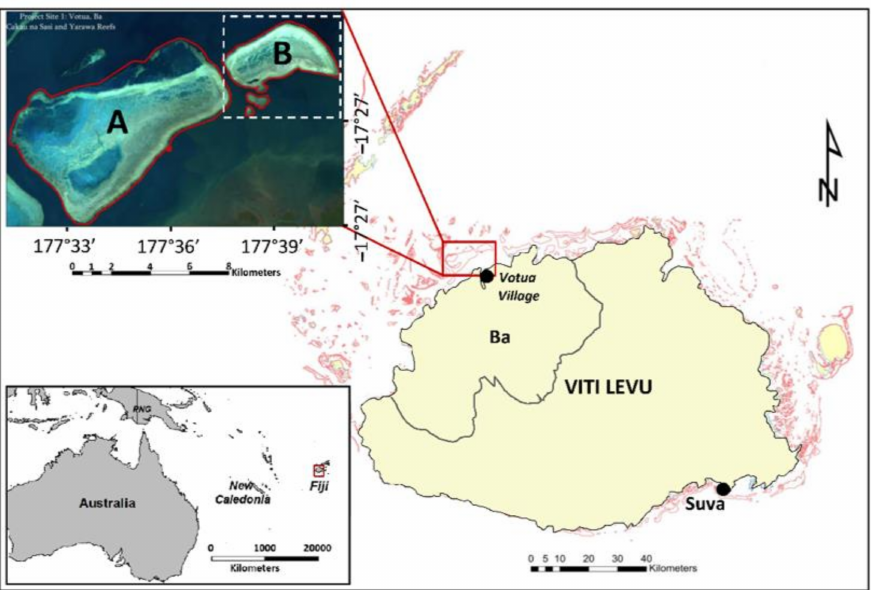
Figure 1. Map showing the study site location at Votua located in the Nailaga district of the Ba region, situated in the north-eastern coastal region of Viti Levu, which is the main island of Fiji. ( A ) Cakaunisasi reef (~50.8 km 2 ) and ( B ) Yarawa reef (12.0 km 2 ). Dashed line—marine protected area